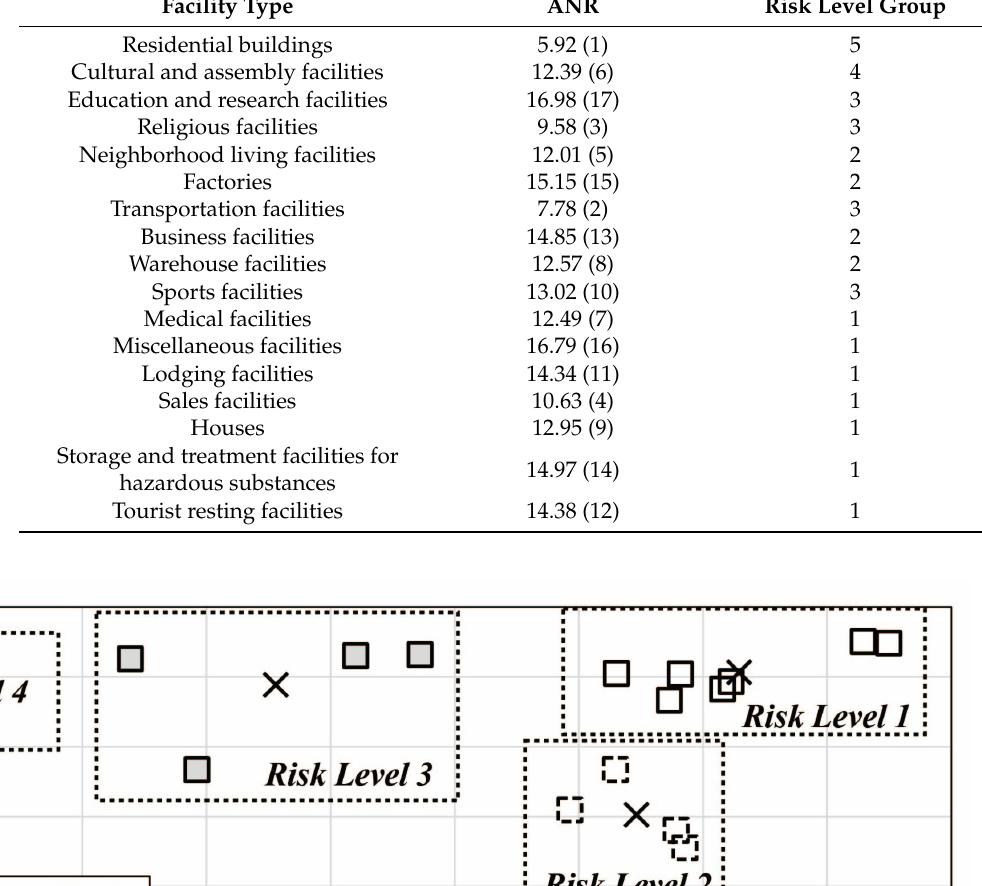
Table 7. Clustering of risk level for 17 construction facility types.